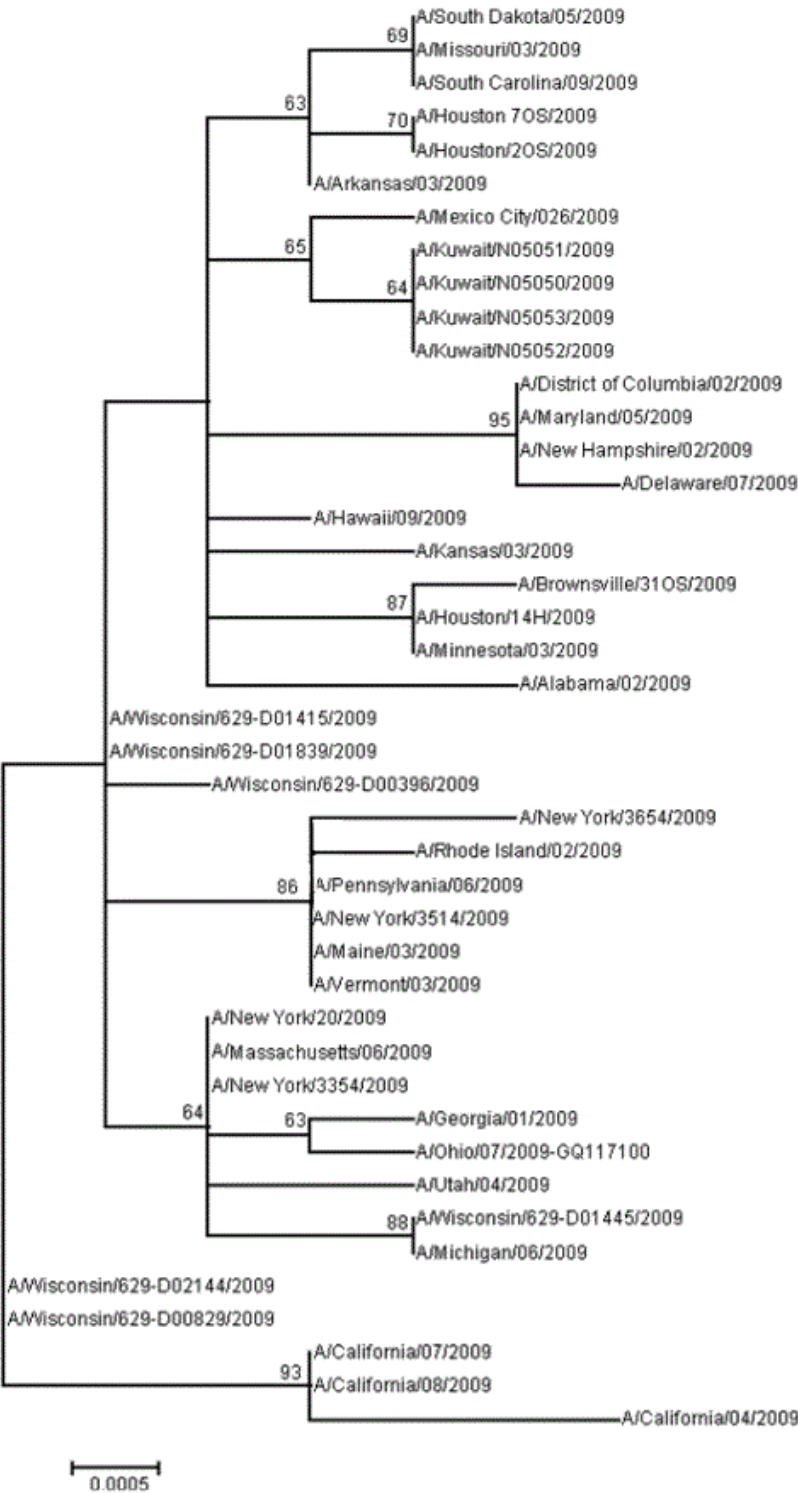
Figure 1. A phylogenetic tree of A(H1N1) pdm09 nucleotide sequences.